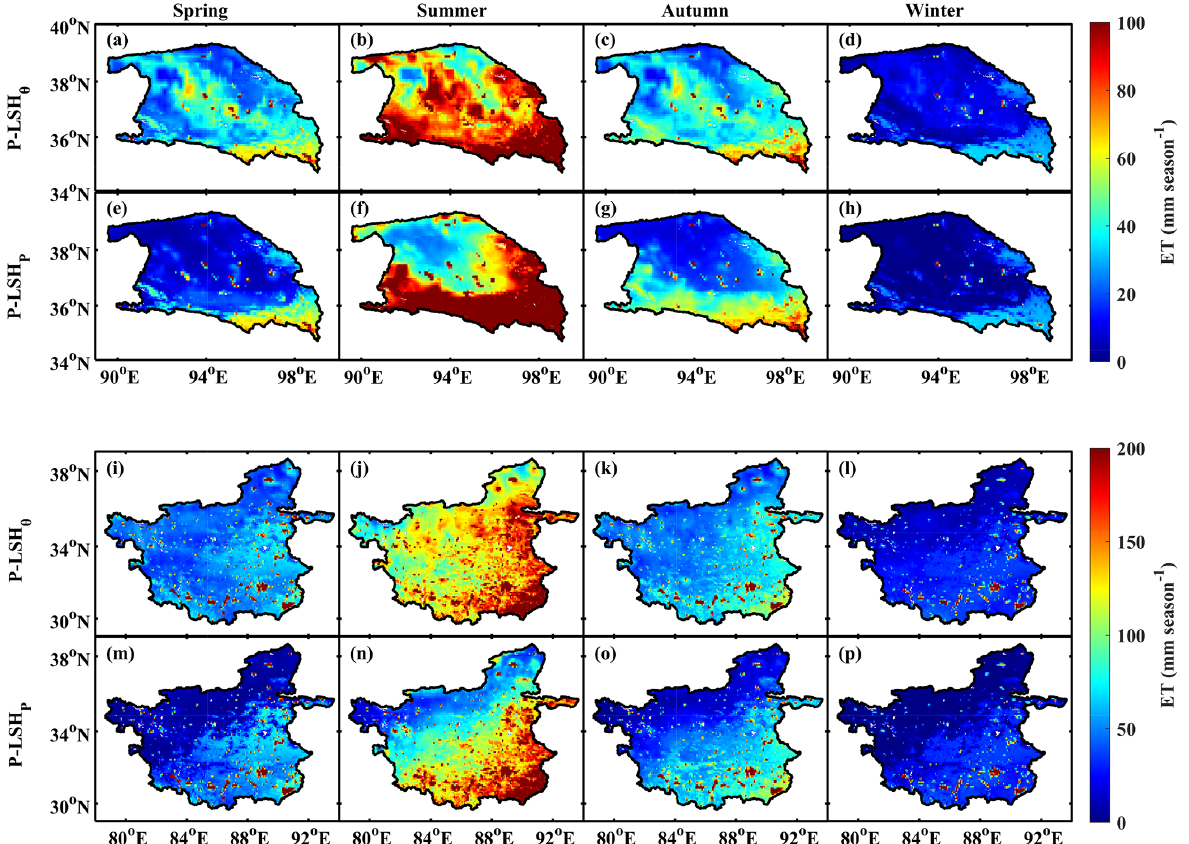
Figure 9. The spatial distributions of multi-year (January 2003–August 2011) seasonal ET derived from (a–d, i–l) P-LSH θ and (e–h, m– p) P-LSH P for (a–h) the Qaidam Basin and (i–p) the Qiangtang Plateau.